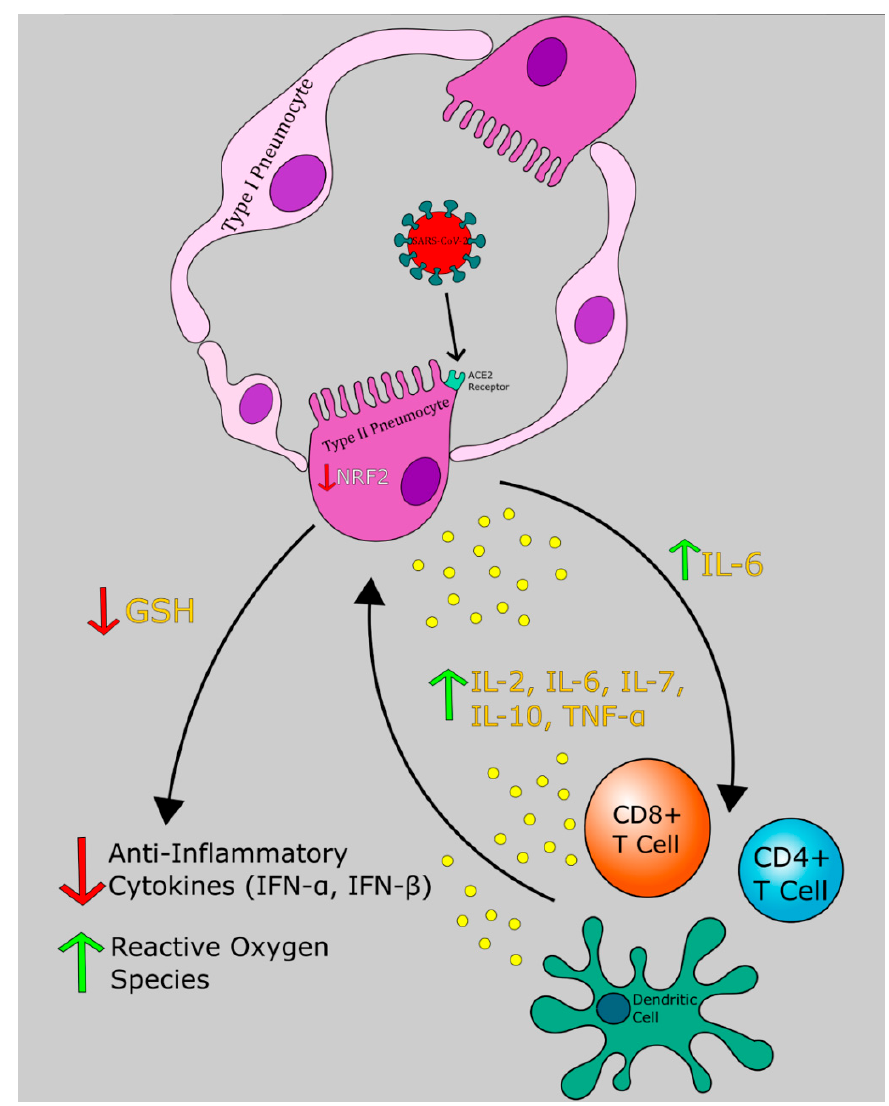
Figure 1. Severe acute respiratory syndrome coronavirus 2 (SARS-CoV-2) induced cytokine storm and redox imbalance. SARS-CoV-2 binds to the angiotensin-converting enzyme 2 (ACE2) receptor and induces down regulation of nuclear factor erythroid 2-related factor 2 (NRF2), which leads to inhibition of glutathione (GSH) release. This results in elevated inflammatory cytokines, elevated reactive oxygen species (ROS), and recruitment of immune cells. Arrows indicate secretion of cytokines and their downstream effectors.